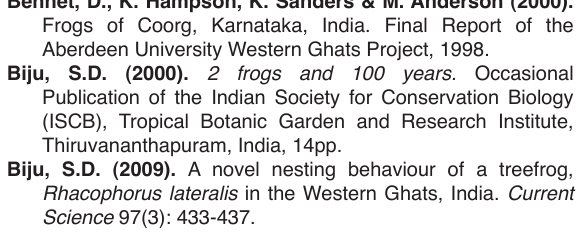
respectively. The species is being reported here for the first time from the surroundings of Bhadra Tiger Reserve and Kudremukh National Park, earlier record being Coorg in the central Western Ghats. Our report extends the range of the species further about 75km (aerial distance) towards the north from Mojo Plantations, Coorg (Goel & Goel 2010) in the Western Ghats. It appears that